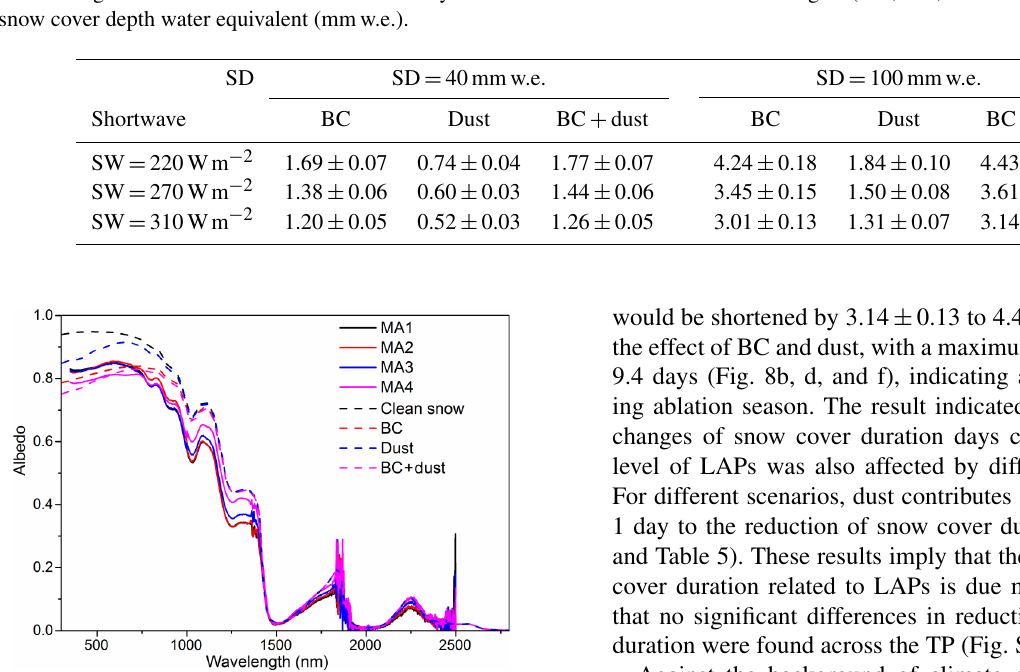
Figure 6. Measured albedo by ASD (solid lines, MA1-4) and simu- lated effects of BC and dust on albedo (dashed lines) at the selected snow site on the Tibetan